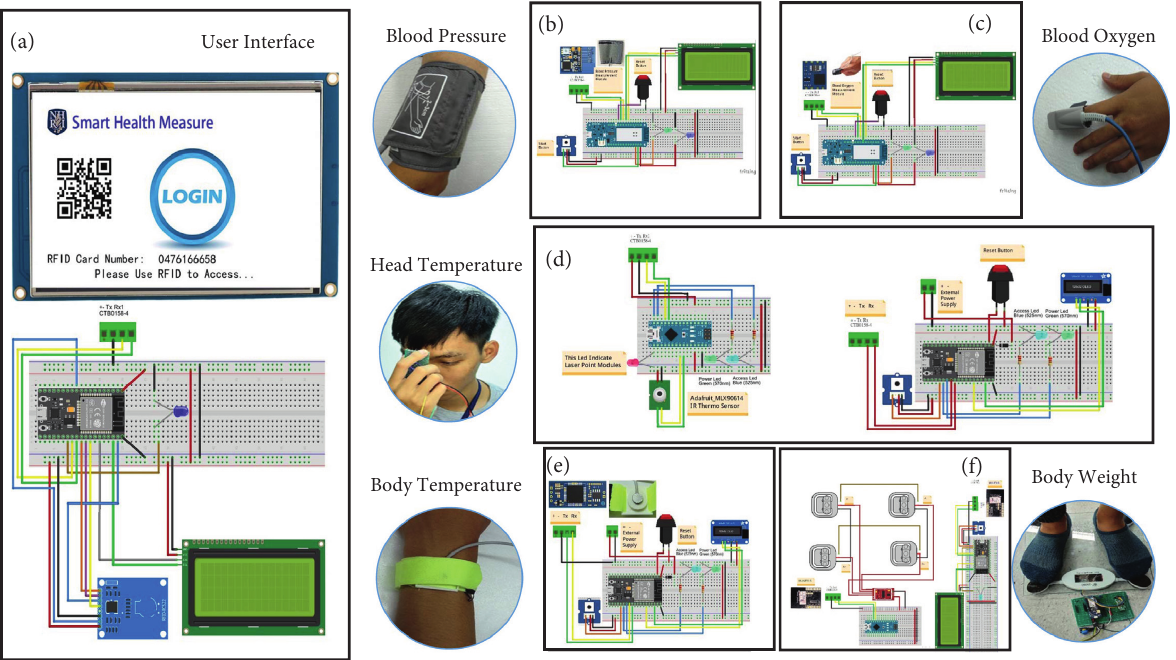
Figure 4: Electronic circuits of all devices discussed in this paper. (a) shows the RFID controller circuits for the MCU (ESP32), a 7 ″ TFT touch screen (Nextion USART HMI) manufactured by ITEAD STUDIO, and an RFID reader (MFC522) manufactured by NXP Semi- conductors. (b) shows the circuits of the blood pressure device for the MCU (Arduino MKR1000), the LCD2004 display, the blood pressure measurement module with an embedded ARM-based MCU modified from a commercial blood pressure product, a user-triggered push button, and a status-indicator light-emitting diode (LED). (c) shows the circuits of the oxygen device for the MCU (Arduino MKR1000), the LCD2004 display, the pulse oximeter with an embedded ARM-based MCU as its controller, a user-triggered push button, and a status- indicator LED. (d) shows the circuits of the head temperature device, which are separated into two parts to include the whole device. The first part is the head temperature probe, which includes the MCU (Arduino Nano), the IR thermo sensor (Nextion, model: LX90614), manufactured by Adafruit Industries, and the status-indicator LED. The second part consists of the controllers, which include an MCU (ESP32), a 0.96 ″ OLED display manufactured by Seed Technology Co., Ltd., a user-triggered push button, and a status-indicator LED. (e) shows the circuits of the body temperature device, which include the MCU (ESP32), a 0.96 ″ OLED display manufactured by Seed Technology Co., Ltd., the high-precision thermistor integrated with a 24-bit ADC developed by this research, a user-triggered push button, and a status-indicator LED. (f) shows the circuits of the body-scale device, which are separated into two parts to include the whole device. The first part is the weight detector, which includes the MCU (Arduino Nano); four load cells (maximum of 50kgW each) combined with a Wheatstone bridge as the weight sensor, which is located under tempered glass to support a human standing on it; and an RF transmitter module (model: MUART0-B) to send data to the weight controller, manufactured by Sunplus Innovation Technology Inc. in Taiwan. The second part is the weight controller, which includes an MCU (ESP32); an LCD2004 display; an RF transmitter module (model: MUART0-B) as the data receiver for the weight detector, manufactured by Sunplus Innovation Technology Inc. in Taiwan; a user-triggered push button; and a status-indicator